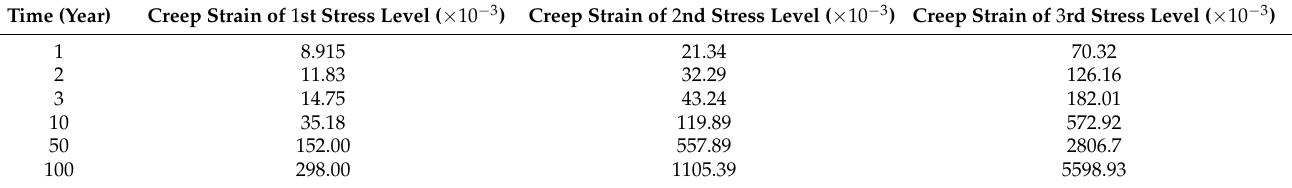
Table 8. Creep strain results for a deep salt mine or cavern based on Equation